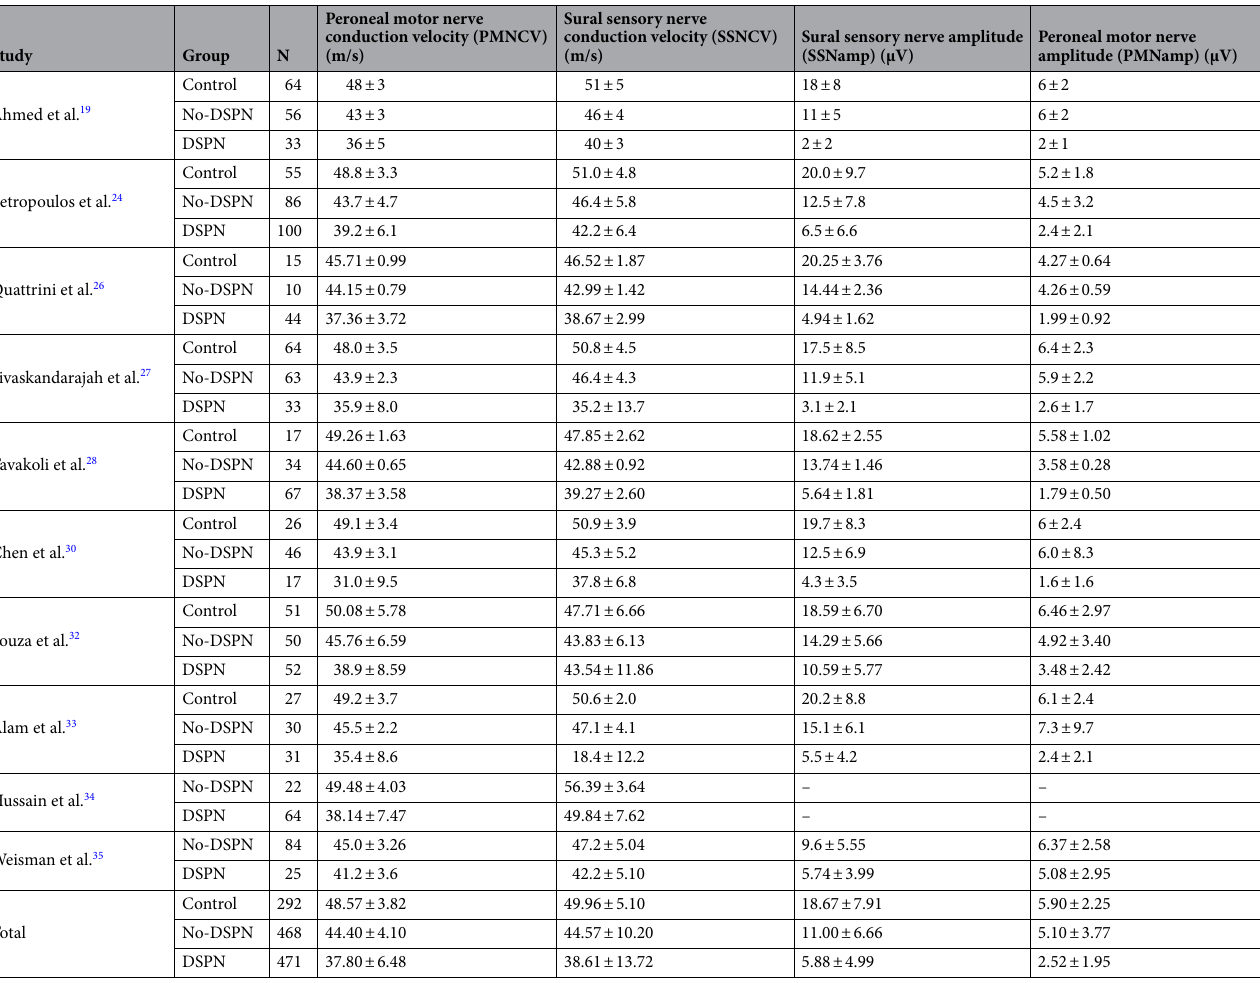
Table 2. NCS Parameter from studies 19,24,26–28,30,32–35